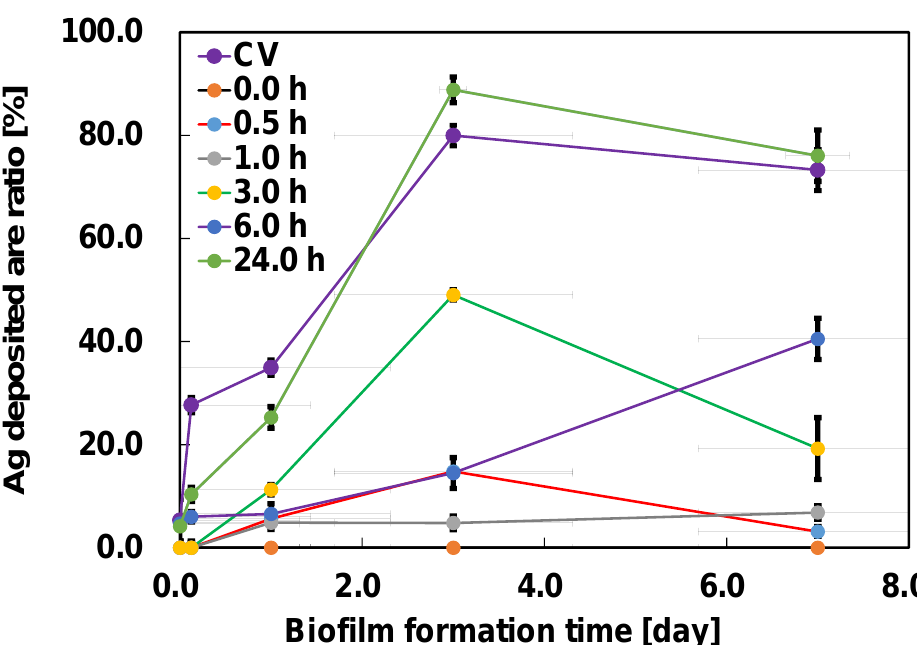
Figure 7. Comparison of Ag and crystal violet dye adsorption behavior.